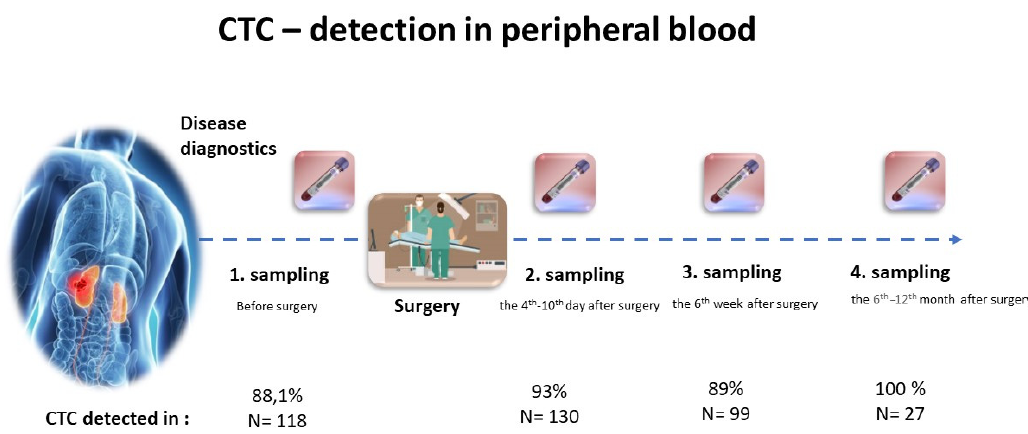
Figure 1. Schedule of blood